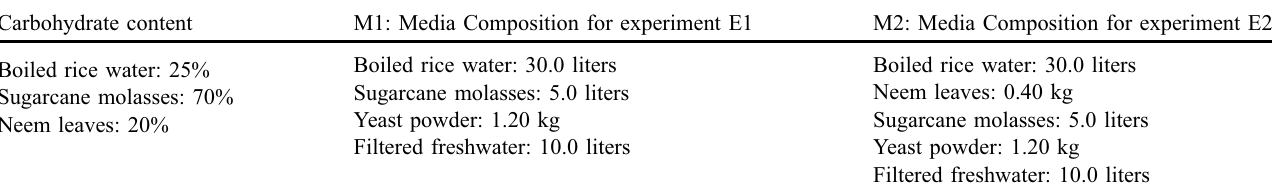
Table 2. Composition of bio fl oc media used in present study. Carbohydrate content M1: Media Composition for experiment